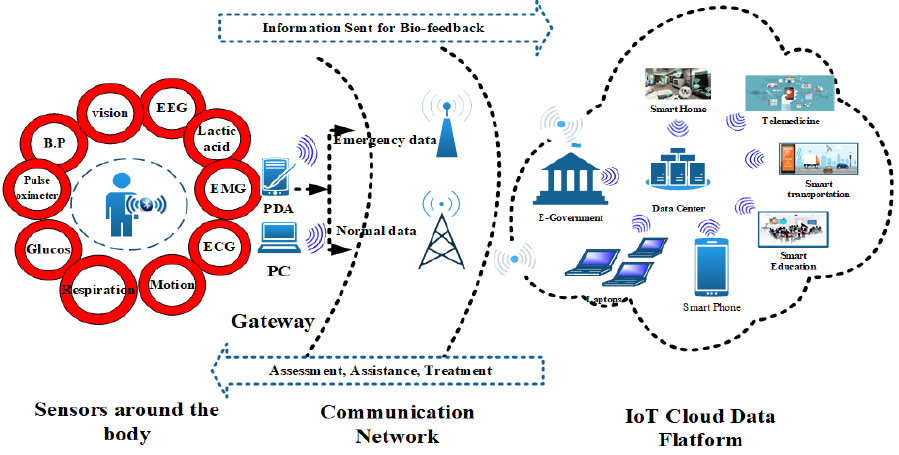
Figure 1. IoT-WBAN Communication structure.